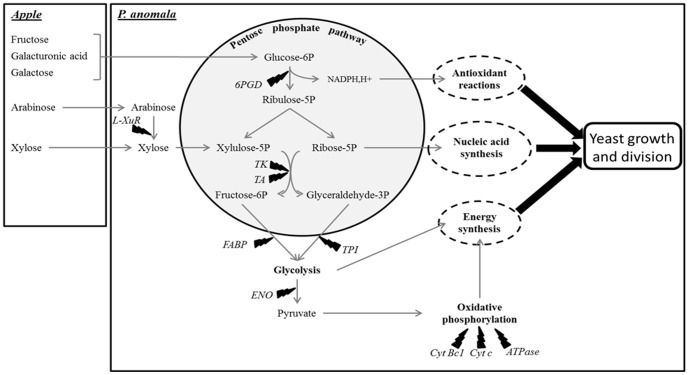
Diagram showing the implication of the pentose phosphate pathway in the mode of action of the antagonist P. anomala.